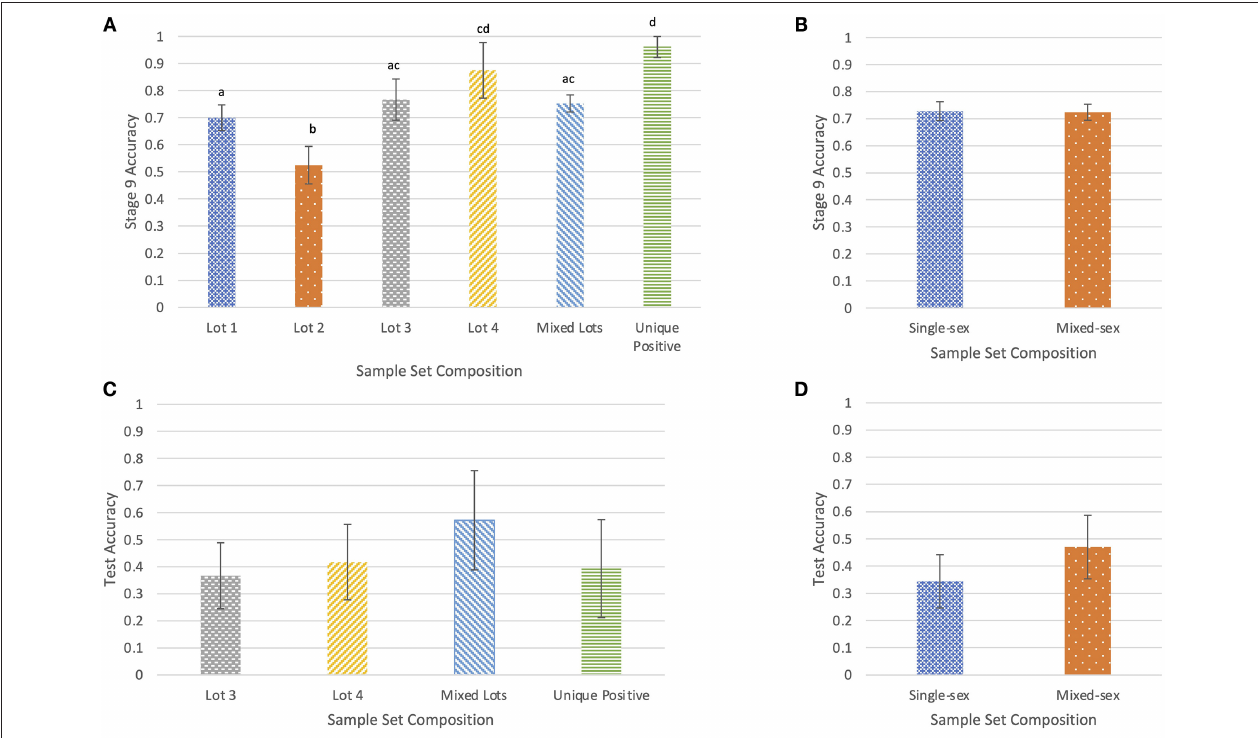
FIGURE 3 | The proportion of correct responses in Stage 9 of training by lot (A) and by sex (B) , and the proportion of correct responses during the double-blind test by lot (C) and by sex (D) . Differing letters indicate significant differences at p < 0.05.